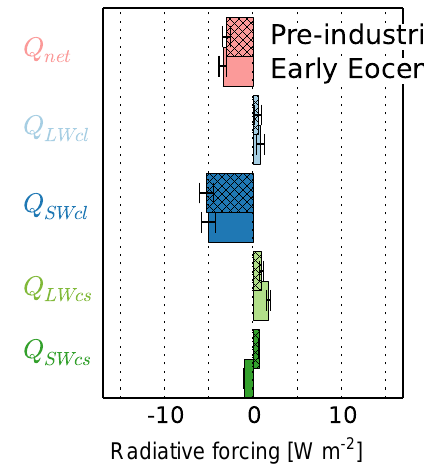
Figure 11. Net radiative forcing and its single components for the comparison of the forest world to the dark desert world. The hatched and the plain bars show the radiative forcings for the pre-industrial climate and the early Eocene climate, respectively. The error bars refer to the 95% confidence